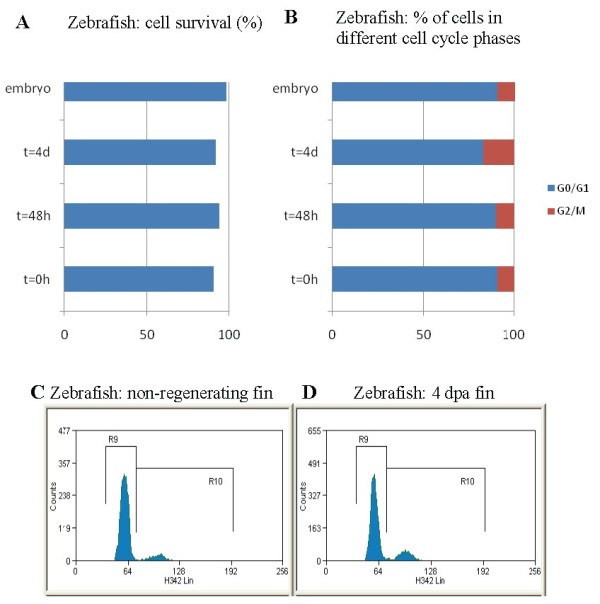
Cell cycle analysis. (A) Cell survival after blastomere and blastemal cell recovery at different time points (0 h, 48 h and 4 d). (B) Representation of cells in G0/G1 (blue) and G2/M (red) cell cycle phases. Results are expressed as percentages. FACS histogram of non-regenerating (C) and 4 dpa regenerating fin blastema cells (D). Cells in G0/G1 are included in R9 and G2/M in area R10.